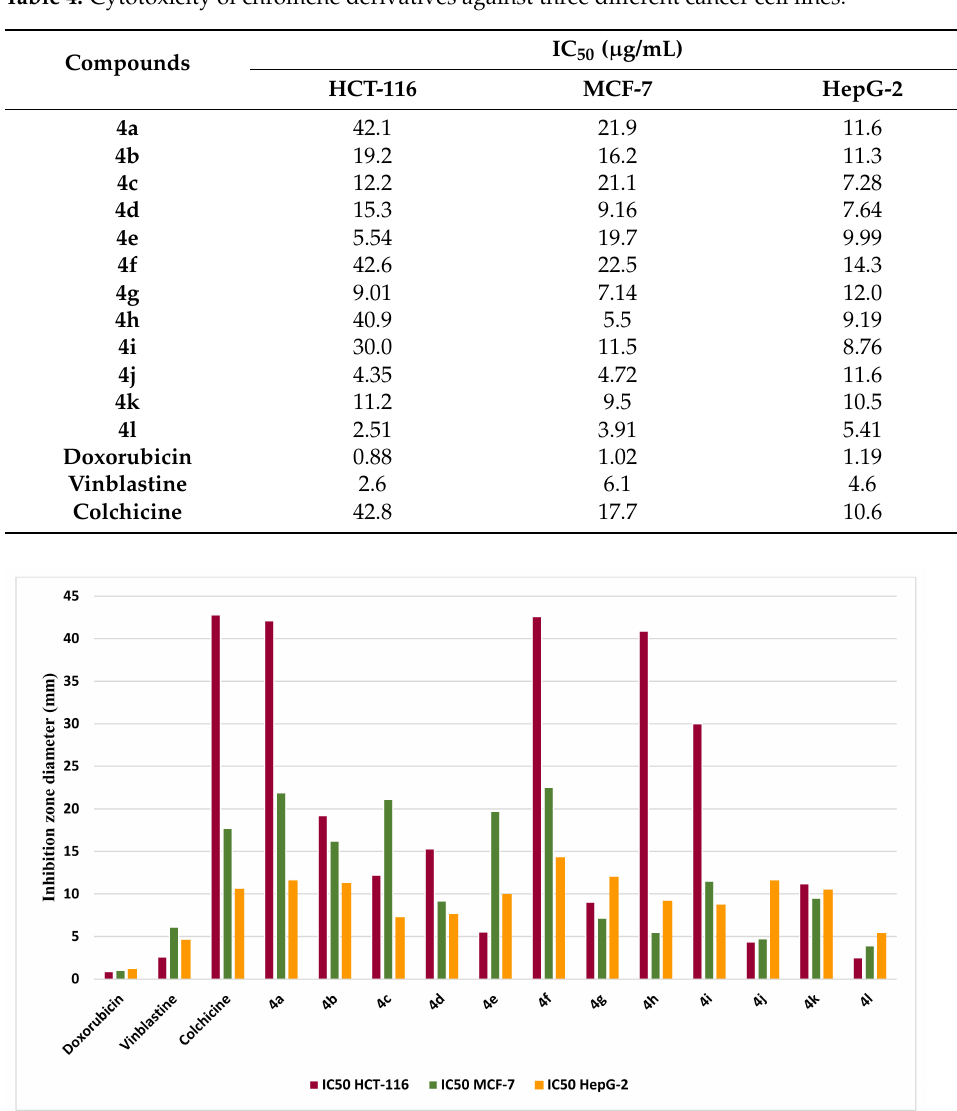
Figure 8. Evaluation of the cytotoxic activity of target compounds compared 4a - 4l to reference